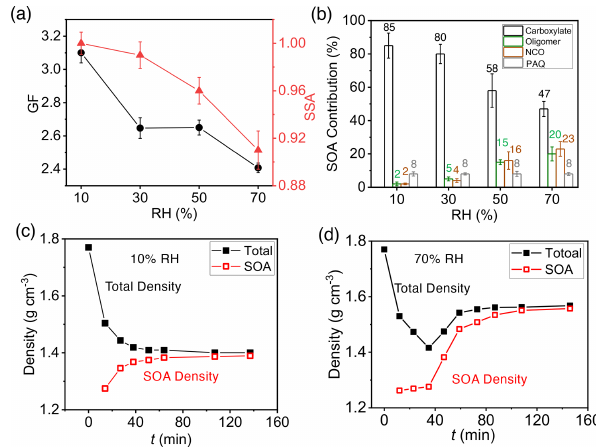
Figure 5. Dependence of SOA/BrC formation on RH. (a) GF (black) and SSA (red) at 120min with varying RH from 10% to 70%. (b) Contribution of COOs to SOA formation with varying RH from 10% to 70%: carboxylate (black), oligomers (green), NCOs (brown), and PAQ (gray) to SOA formation. The number denotes the percentage contribution (%) of each type of aerosol-phase prod- ucts. (c, d) Time-dependent particle (black) and SOA (red) den- sities of seed particles exposed to m -xylene oxidation products at RH = 10% (c) and 70% (d) , respectively. The error bar denotes 1 σ of three replicated